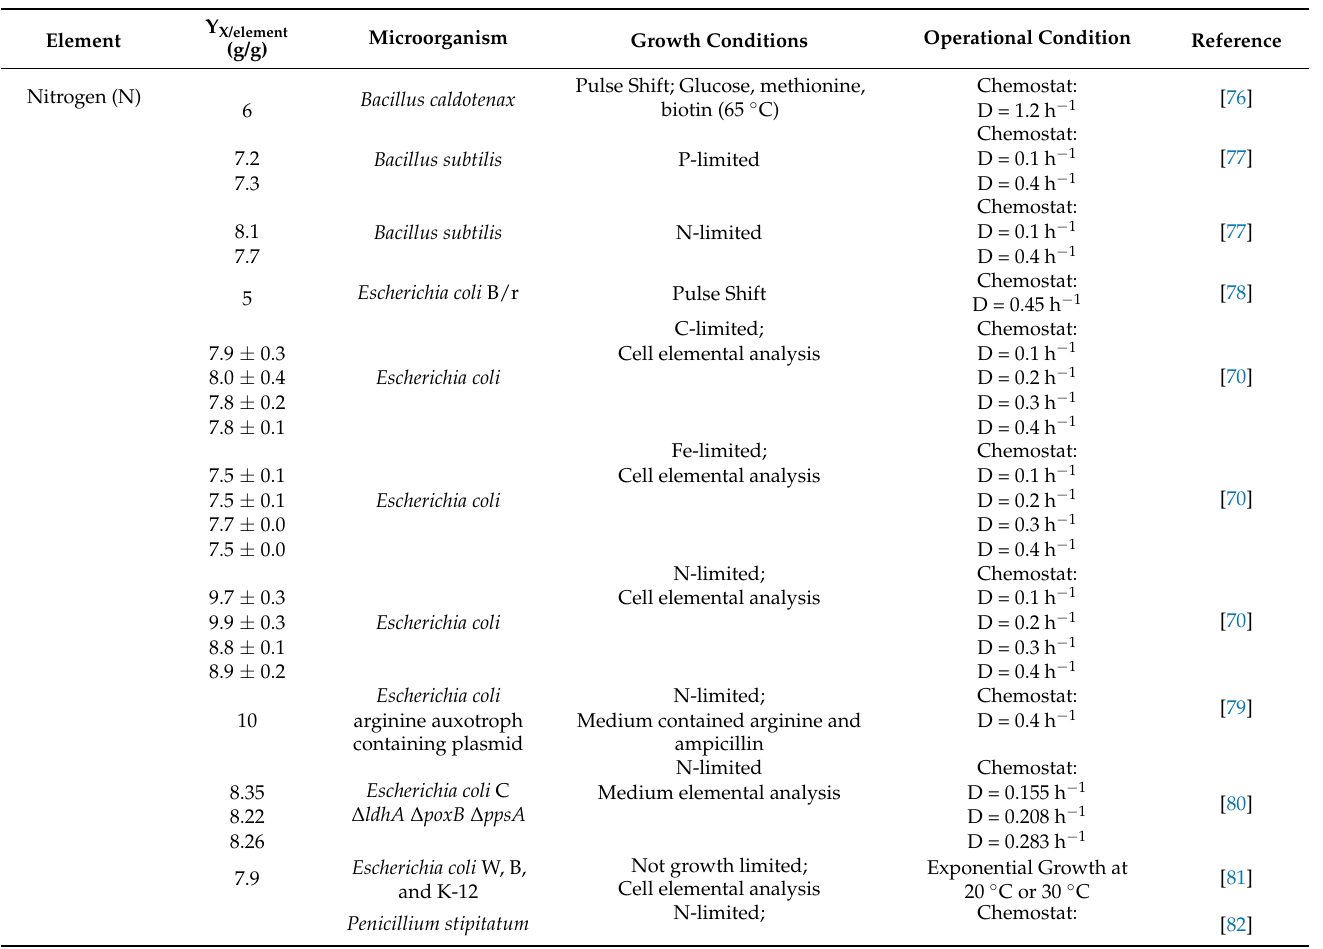
Table 1. Reported yield coefficients for elements using various microorganisms. Where necessary, reported data have been converted so that the yield coefficient is defined as the mass of cells on a dry basis generated per mass of that element consumed (g cells/g element). Each element is available in the medium as a salt or other metabolizable